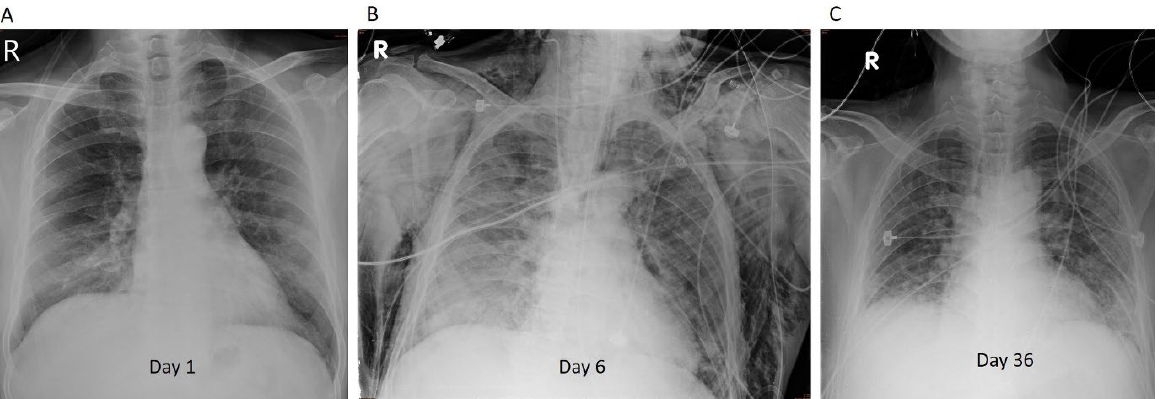
Figure 2. Representative case 2 (Patient 5): ( A ) Bilateral opacities were observed on chest radiography taken in emergency department. ( B ) On Day 6, chest radiography revealed patchy opacities in the right lower lung and bilateral subcutaneous emphysema. ( C ) On Day 36, improvement was observed on chest X-ray.